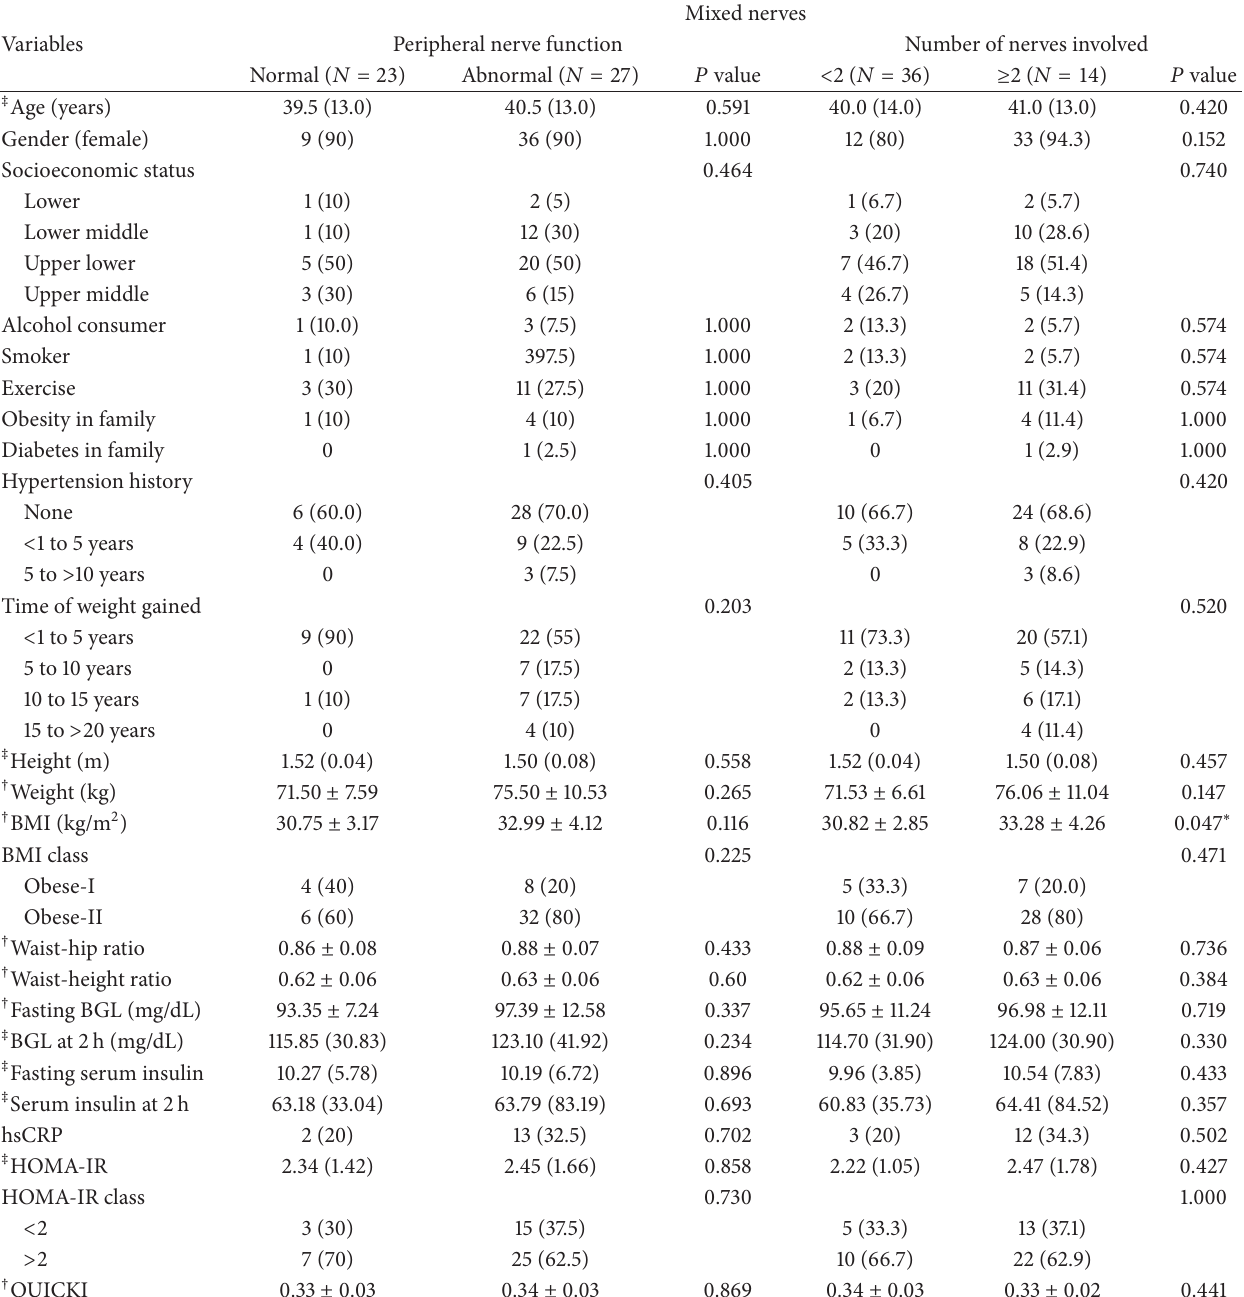
Table 4: Baseline characteristics of volunteers according to the total nerve. The values in the column of the mixed nerves outside the small bracket are the count per total and those inside the bracket are the